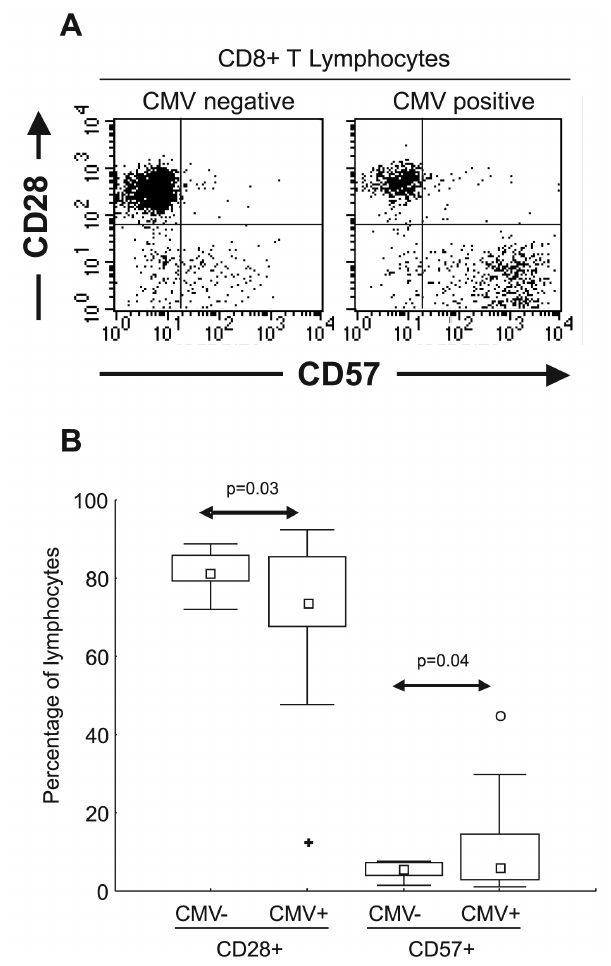
Figure 1 - (A) Graphic representation of CD8+ T lymphocytes (using CD3+CD8+ dual staining over a lymphocyte gate) from CMV seronegative and CMV seropositive healthy subjects. Expression of CD28 and CD57 were essentially mutually exclusive. (B) Distribution of CD28 and CD57 in 9 CMV seronegative (CMV-) and 24 CMV seropositive (CMV+) healthy subjects. Statistically significant differences were observed in the distribution of both subsets correlating with CMV serostatus (arrows)  Median;  25%-75%; —| Non-Outlier Min-Max;  Outliers; 